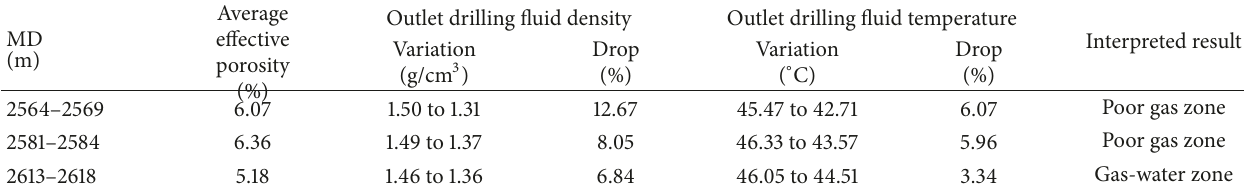
Table 2: Real-time logging interpretation results for PL113 well intervals.